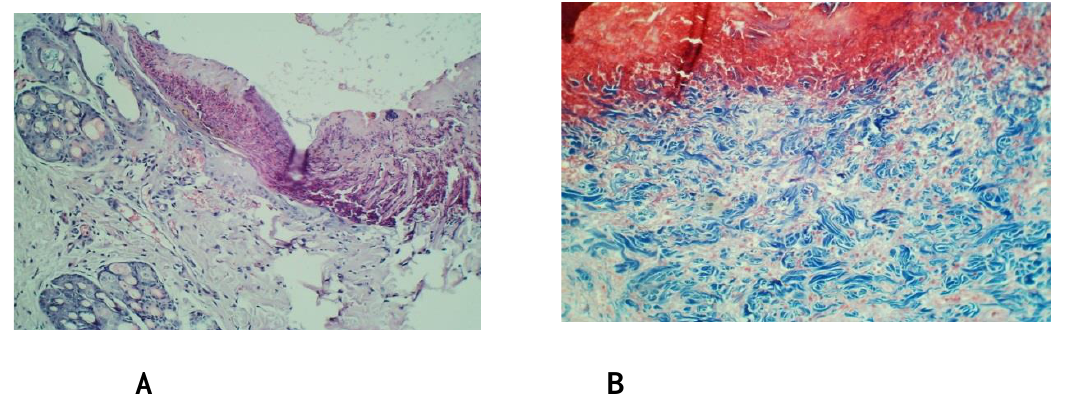
Figure 4: View of Myrrh oil at day 3 showed ,A: scab, new epithelium , inflitrationof inflammatory cells and hair follicle, H&E,X10.B: new fine collagen fiber, MT,X40. Seven days duration(Control group) Fig .